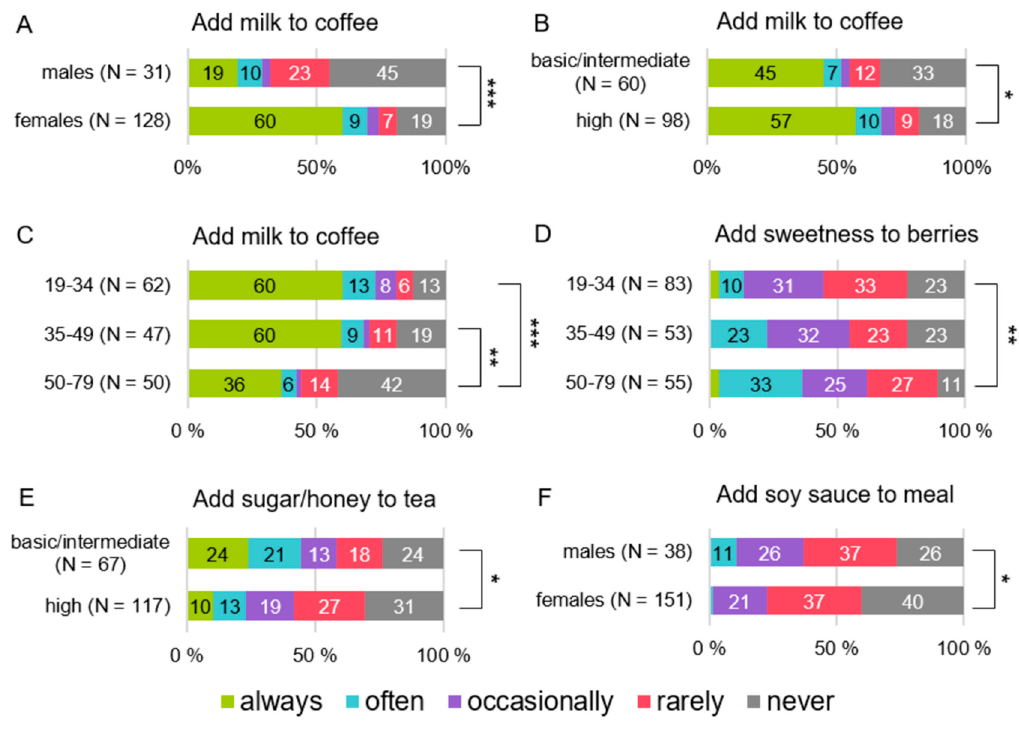
Figure 2. Significant group differences in frequency to mask/modify tastes. ( A ) sex vs. the habit of adding milk to coffee, ( B ) education vs. the habit of adding milk to coffee, ( C ) age (years) vs. the habit of adding milk to coffee, ( D ) age (years) vs. the habit of adding something sweet to berries, ( E ) education vs. the habit of adding sugar/honey to tea, ( F ) sex vs. the habit of adding soy sauce to a meal when eating it. * p < 0.05, ** p < 0.01, *** p < 0.001 based on the Mann-Whitney U test.